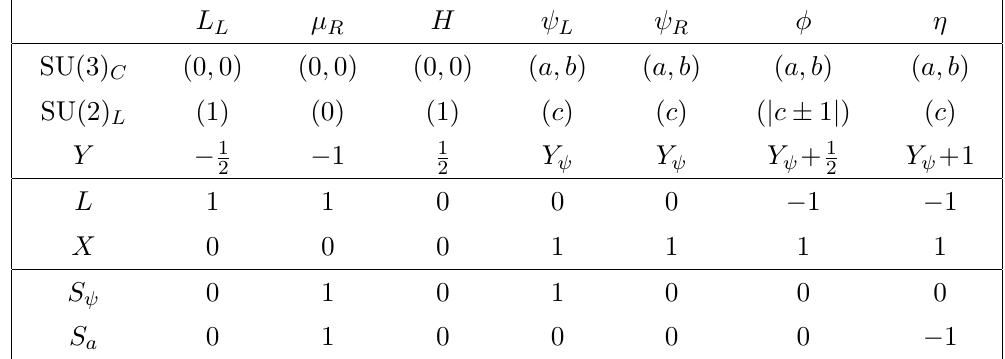
Table 1 . Quantum numbers of fields for Class 1 models. The first two lines give the allowed Dynkin labels for the non-Abelian